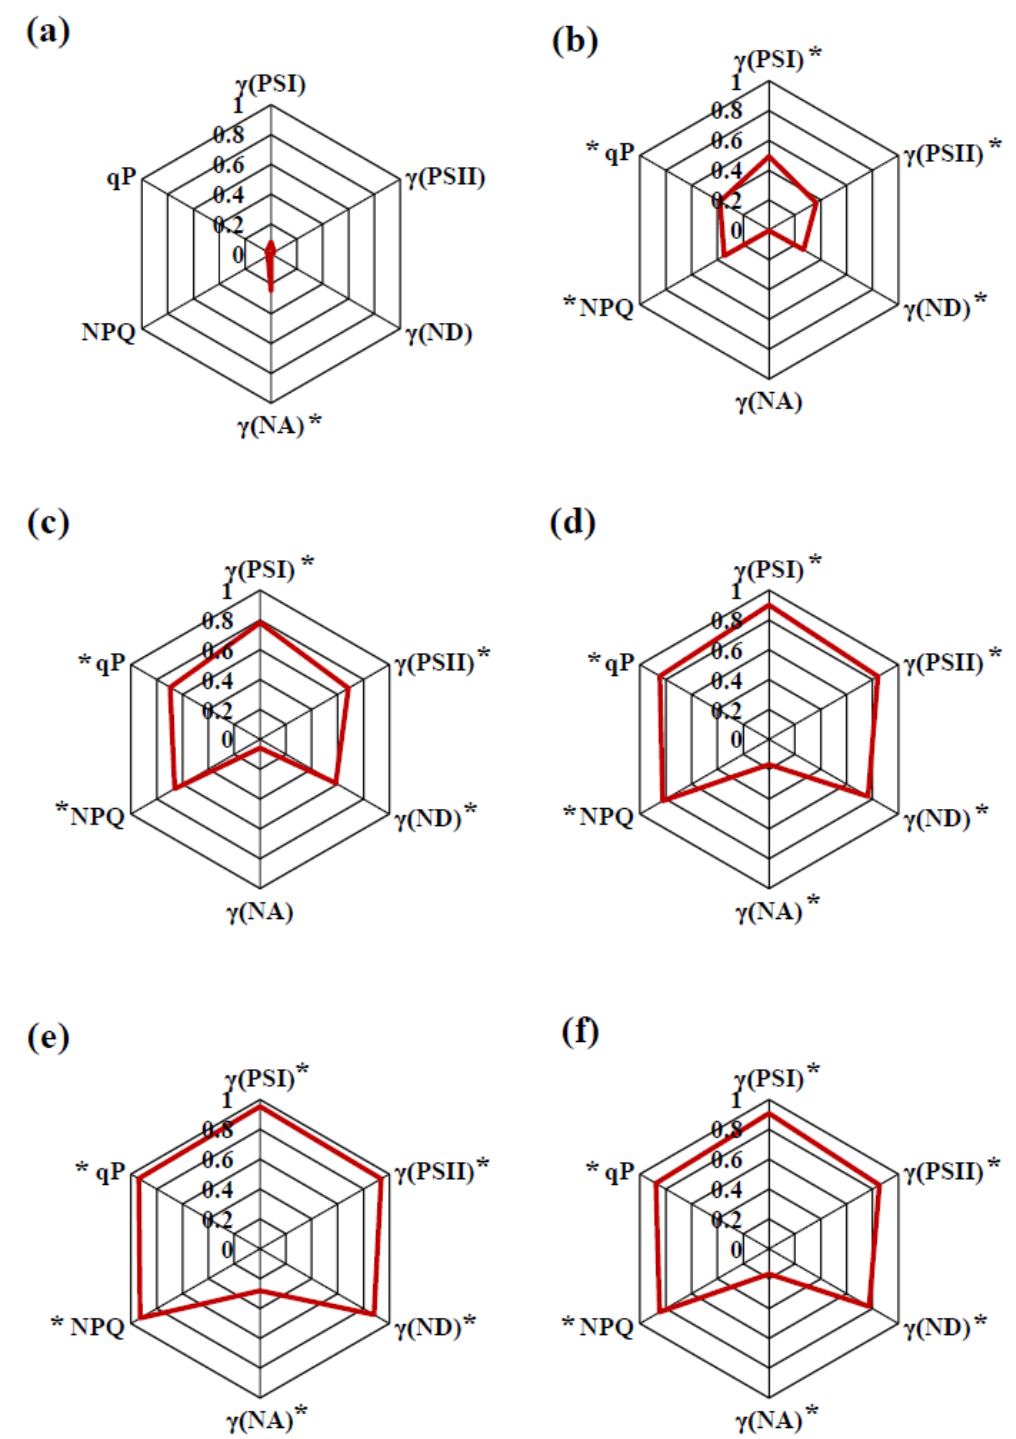
Figure 5. Determination coe ffi cients (R 2 ) for the linear regressions, which were calculated on the basis of all of the averaged experimental values of the photosynthetic parameters and ∆ PRI(515,570) ( a ), ∆ PRI(525,570) ( b ), ∆ PRI(531,570) ( c ), ∆ PRI(535,570) ( d ), ∆ PRI(545,570) ( e ), and ∆ PRI(555,570) ( f ). The coe ffi cients were calculated on the basis of the results from Figures 2 and 3; details of the relations are shown in Figures S1–S6 (Supplementary Materials). * indicates that the relation was significant ( p < 0.05 for the correlation coe ffi cients between these values).